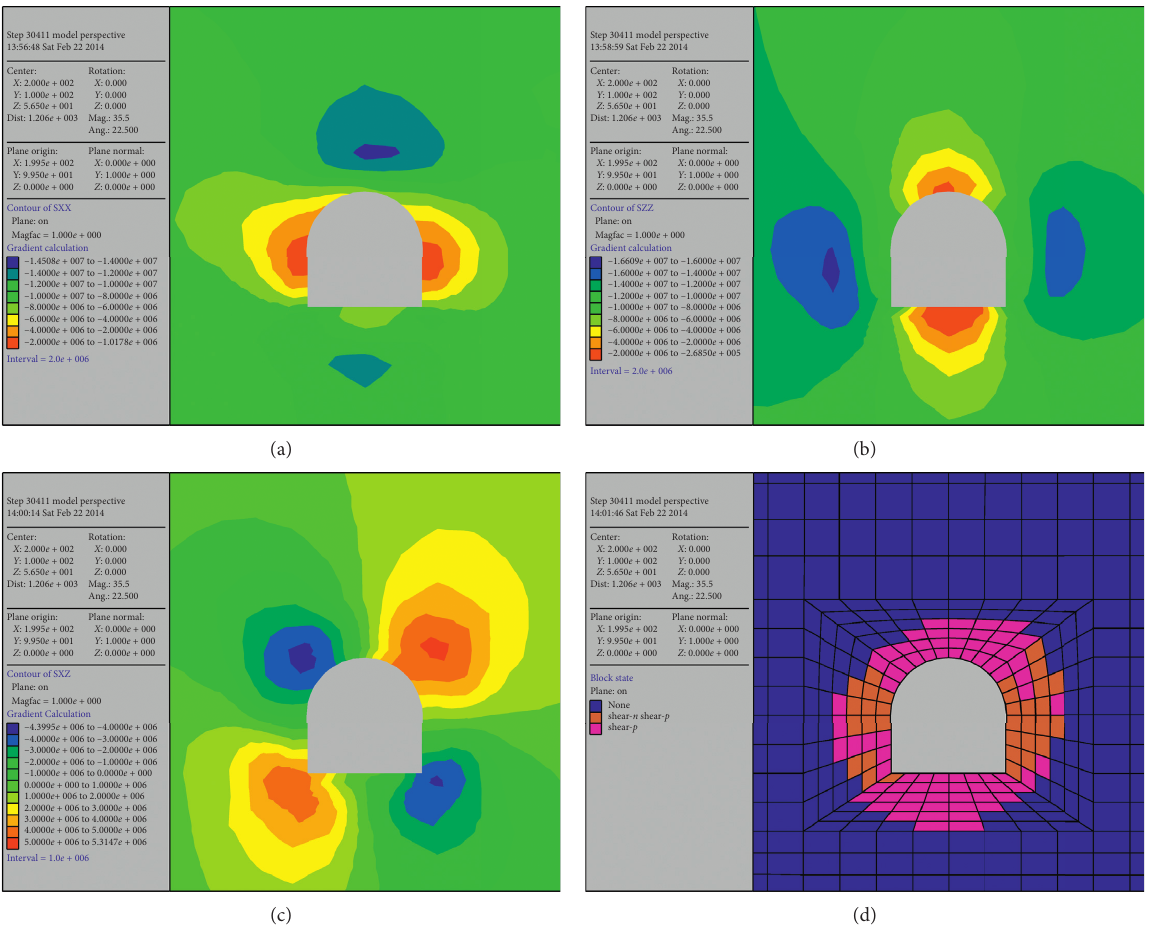
Figure 8: The stress state of the roadway. (a) Horizontal stress nephogram. (b) Vertical stress nephogram. (c) Shear stress nephogram. (d) Distribution of the plastic area.